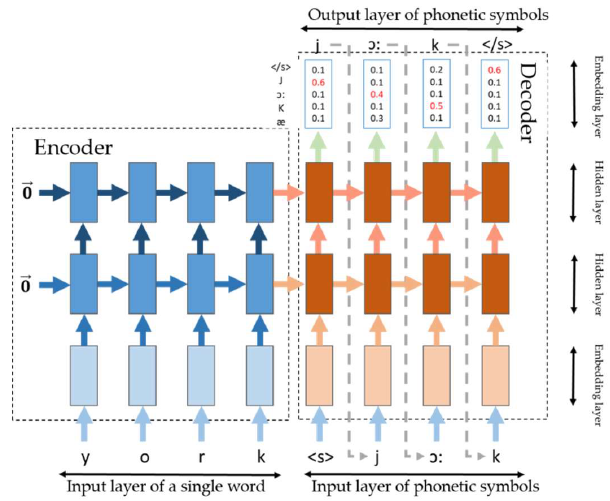
Figure 5. Framework map of the network model for phonetic symbol generation.